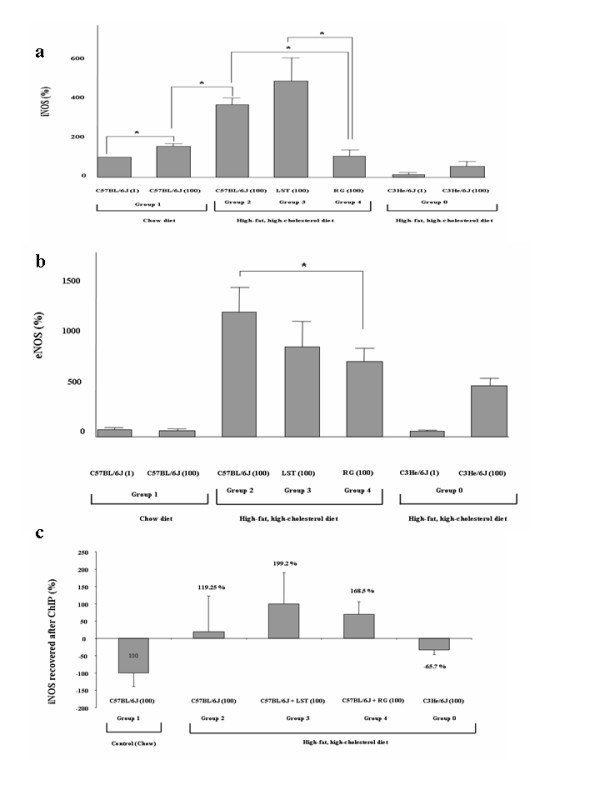
Treatments modified iNOS gene expression while PPARγ-mediated iNOS amplification levels were similar. (a) iNOS mRNA relative expression in pooled liver samples from analyzed groups normalized to GAPDH expression. *P < 0.05. (b) eNOS mRNA relative expression in pooled liver samples from analyzed groups normalized to GAPDH expression. Results are expressed as mean ± SEM percentage of mean values obtained from equal numbers of C57BL/6J and C3He/6J mice. *P < 0.05. (c) ChIP with a PPARγ antibody of study groups was used to amplify an iNOS promoter fragment. ChIP figures percentages indicate increments or decrements regarding C57BL/6J mice fed HFHC diet. Data of C57BL/6J mice fed chow diet was established as 100%.